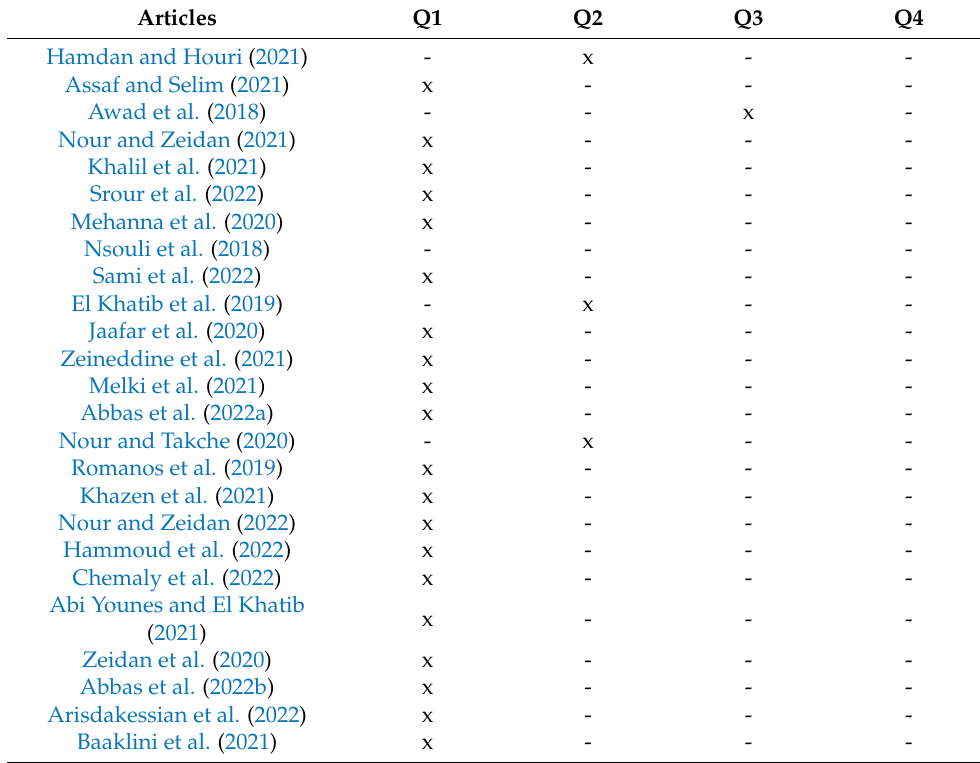
Table A2. Published papers in the School of Arts and Sciences per quartile,